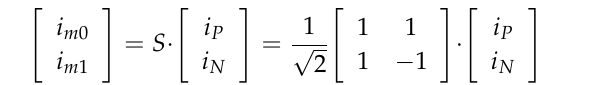
Figure 4. Algorithm for fault location of a two-segment line.